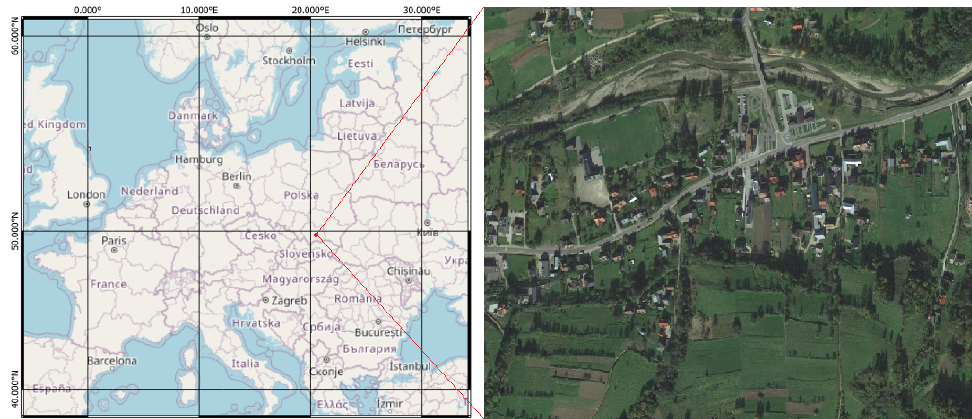
Figure 1. Location of conducted research work: 49°31 ′ 31.6 ″ N 20°19 ′ 13.0 ″ E—Ochotnica Dolna, Małopolskie Voivodeship, Poland.